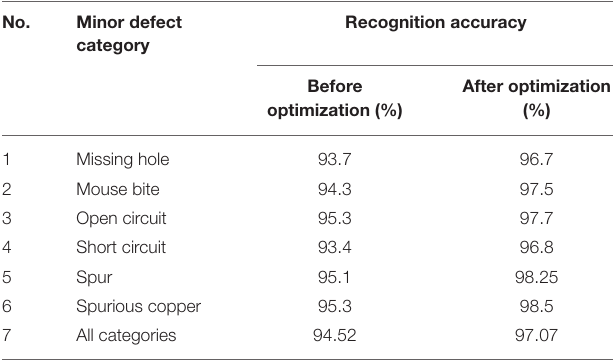
TABLE 2 | Comparison of the number of minor defects before and after data